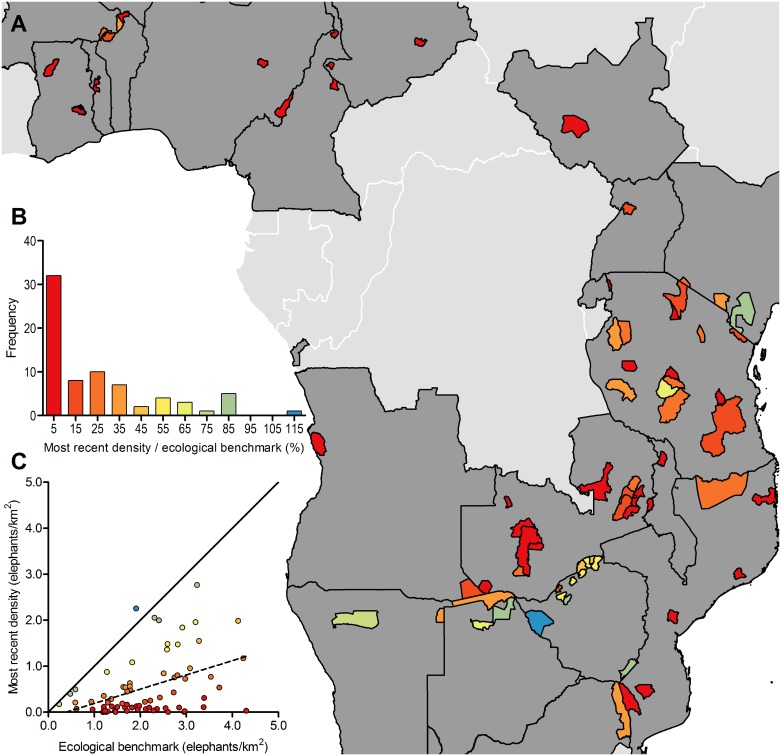
Most recent density estimates as a percentage of predicted ecological benchmark densities for savanna elephant populations across 73 protected areas indicate most populations are far from ecological benchmarks.(A) Fill color illustrates most recent density estimates as a percentage of predicted ecological benchmark density as indicated in (B) the frequency distribution where percentages on the x-axis represent bin centers. (C) Populations plotted according to the same color scheme show that while few populations are near their predicted ecological benchmark (indicated by the solid 1:1 line), recent density estimates increased with predicted ecological benchmark density (dashed line: y = 0.31x-0.12, F1,71 = 16.38, p<0.001, R2 = 0.19).